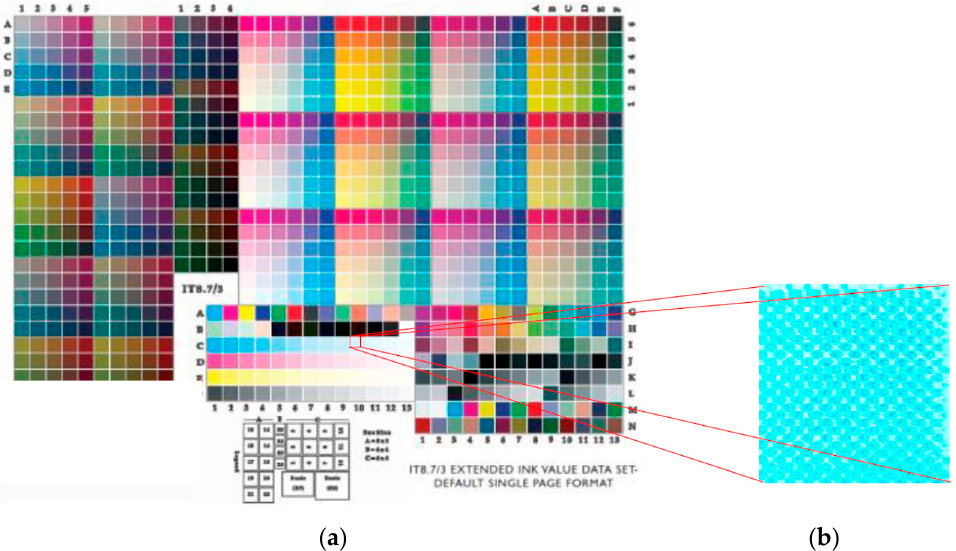
Figure 2. ( a ) Example of selected samples from the IT8.7/3 Color Chart: sample C10—Cyan with 20% ink coverage; sample D10—Magenta with 20% ink coverage, sample E10—Yellow with 20% ink coverage, ( b ) cropped image of a rotogravure printed cyan sample magnified ×5.